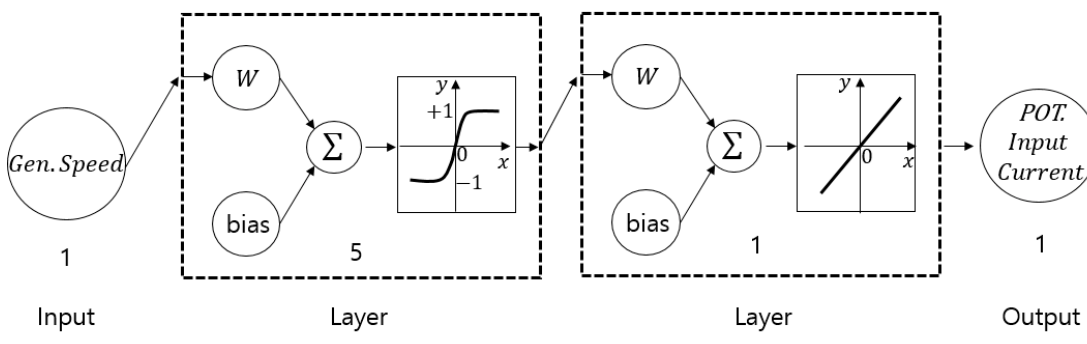
Figure 8. Flowchart of training algorithm for neural network . Figure 9a presents the rotational speed data of the variable speed synchronous generator engine, which was used as the input pattern of the neural network; Figure 9b presents the data of the potentiometer input current, which was used as the output pattern. Figure 9c presents the output result of the current output with respect to the input of the potentiometer, with the speed command of the synchronous generator, which was the input value of the neural network. Moreover, the speed changed in the order of 1800 → 1100 → 1800 rpm after the configuration of a neural network controller input with